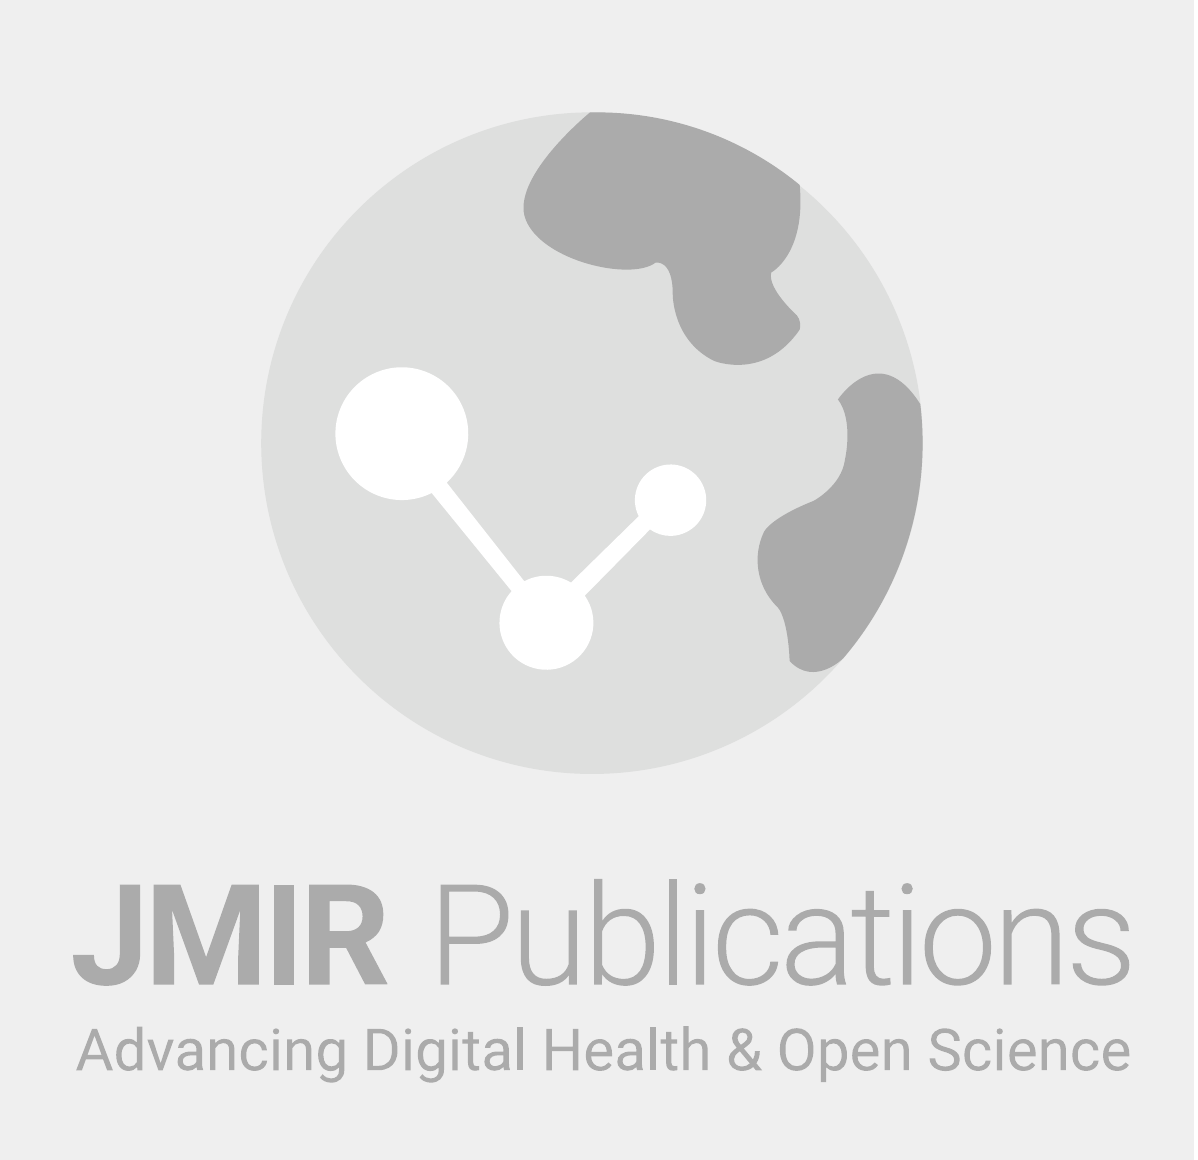
Figure 1b. Prosdex